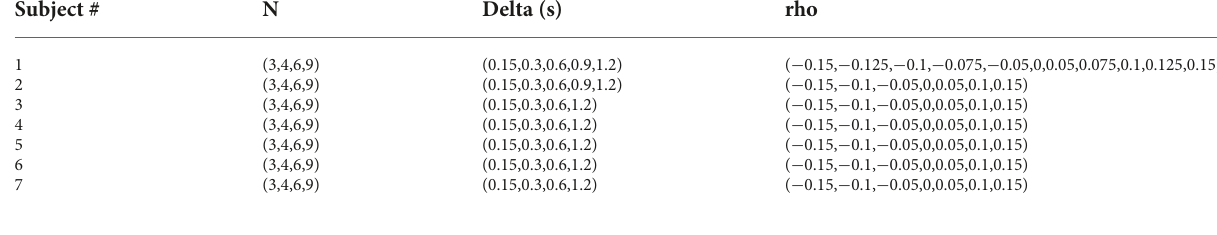
TABLE 1 Experimental parameters for each